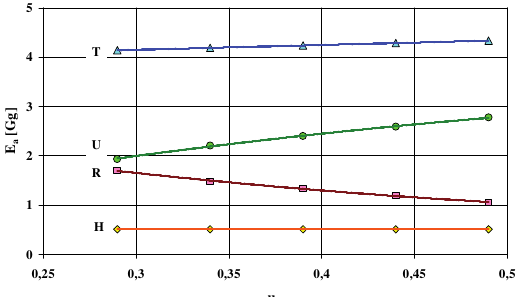
Fig. 4. Dependence of the national annual emission of particulate matter PM10 from tribological elements of passenger cars upon the road length travelled under the following model traffic conditions: U – urban, R – rural, H – on highways and expressways and T – under all conditions